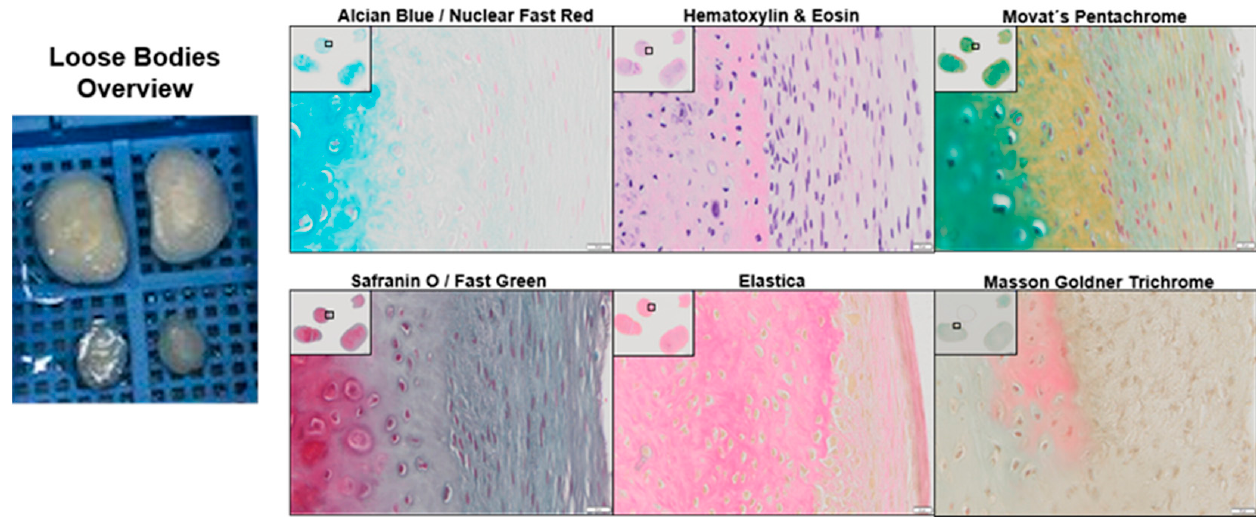
Figure 1. Histological staining of various regions from LB patient samples. In the top left corner are 4 × overviews (total 40 × magnification) and in the black square the selected regions for the 20× (total 200 × ) magnification. The scale bar equals 50 µ m. For detailed explanation of the staining and the staining codes, see text Section 2.1 and Figure A1.